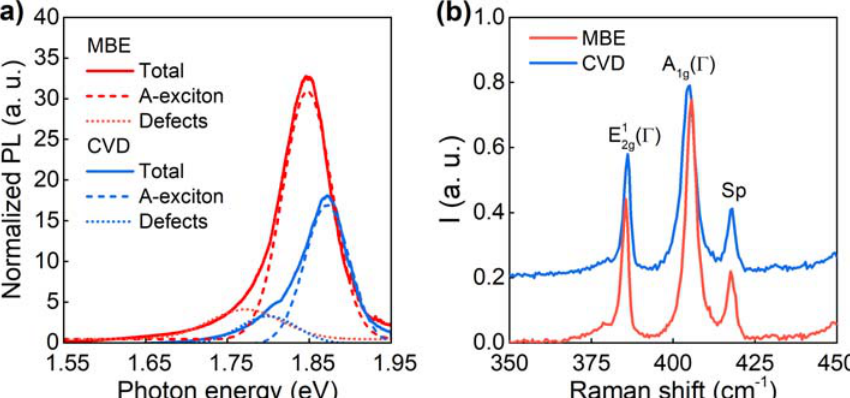
Figure 2. Photoluminescence ( a ) and Raman ( b ) spectra of the CVD and epitaxial monolayer MoS 2 grown on sapphire substrates. The excitation wavelength was 632.8 nm ( a ) and 532 nm ( b ). Dashed and dotted lines show deconvolution of the photoluminescence spectrum into Gaussian peaks corresponding to A-exciton and defects, respectively. The Raman peak marked as “Sp” is related to the sapphire substrate.